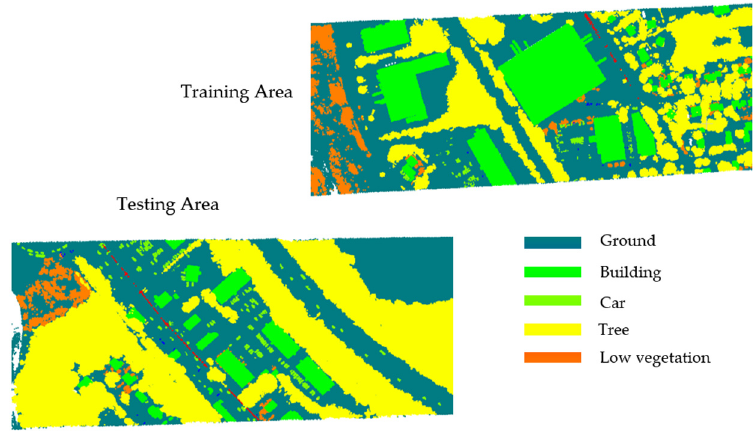
Figure 8. GML Dataset A.